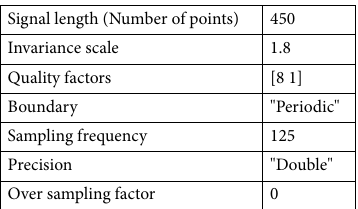
Table 2. Wavelet scattering decomposition frame